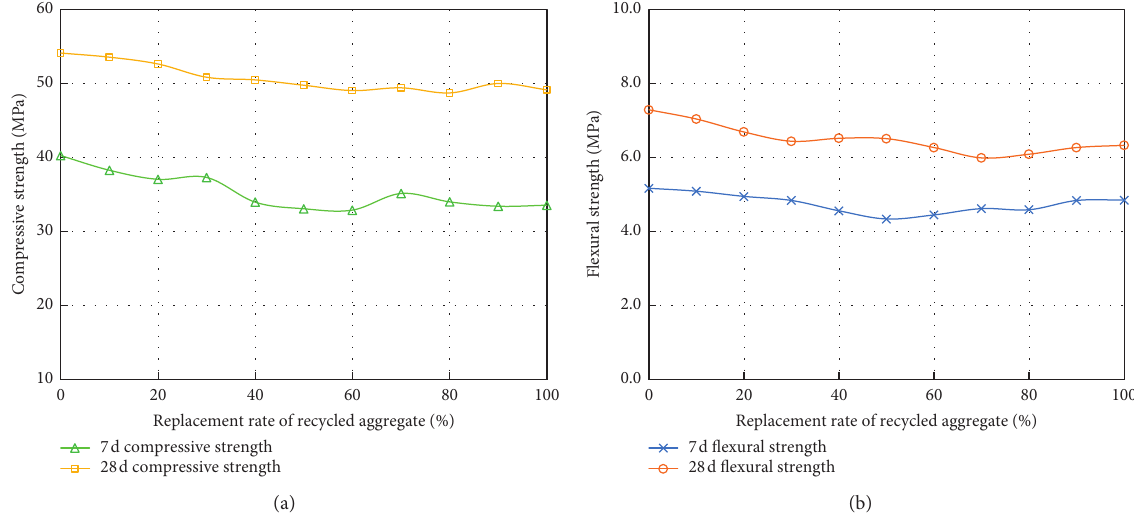
Figure 3: Strength of recycled aggregate concrete with different replacement rates. (a) The compressive strength. (b) The flexural tensile